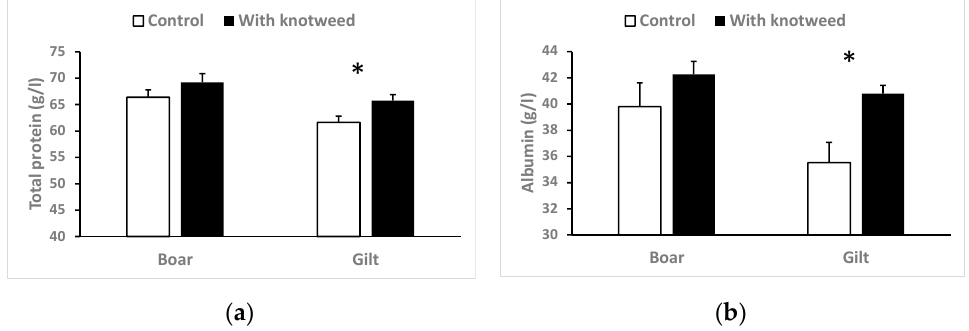
Figure 6. Total serum protein ( a ) and serum albumin ( b ) in the experimental group of pigs and the control group of pigs according to sex at the end of the experiment. Means + SEM. Difference significant on p < 0.05 marked by an asterisk.